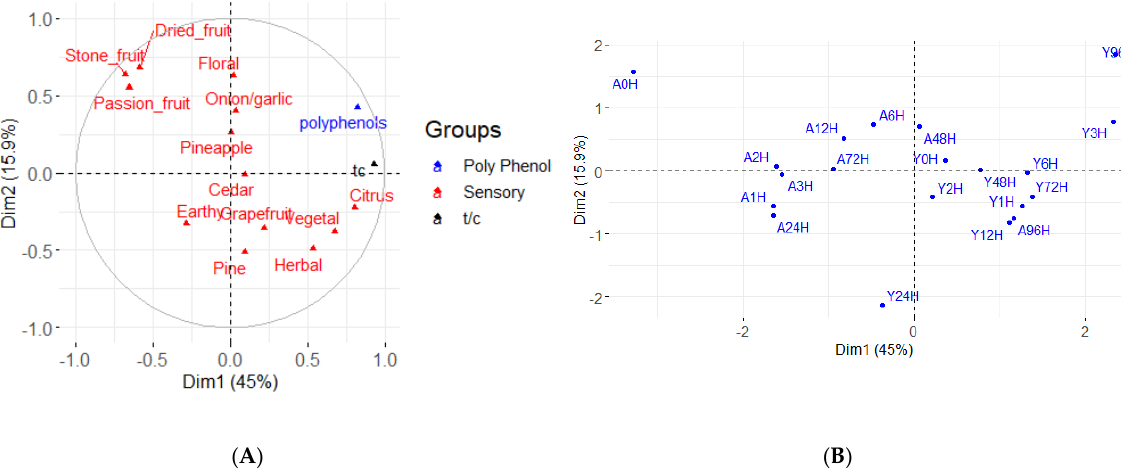
Figure 7. Multifactor analysis of t / c ratio, polyphenols, and sensory data of Young (Y) and Aged (A) beers. ( A ). Variable plot. ( B ) Score plot of individual treatments.